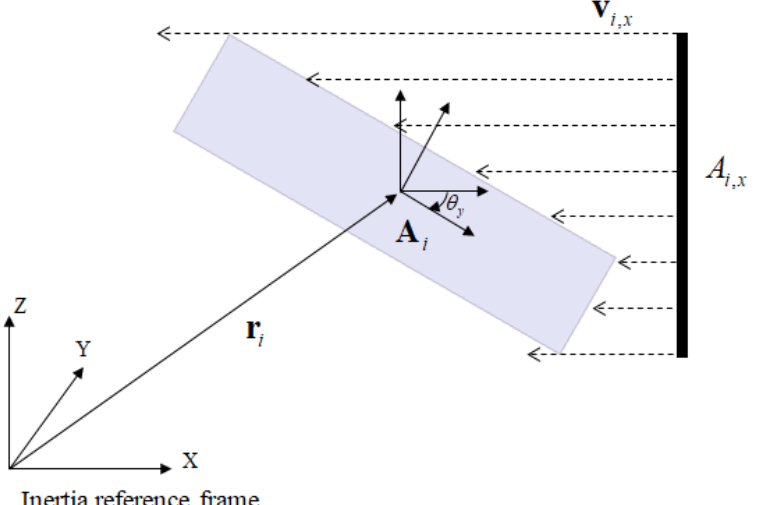
Figure 3. Calculation method of the area of drag force acting on a single body.